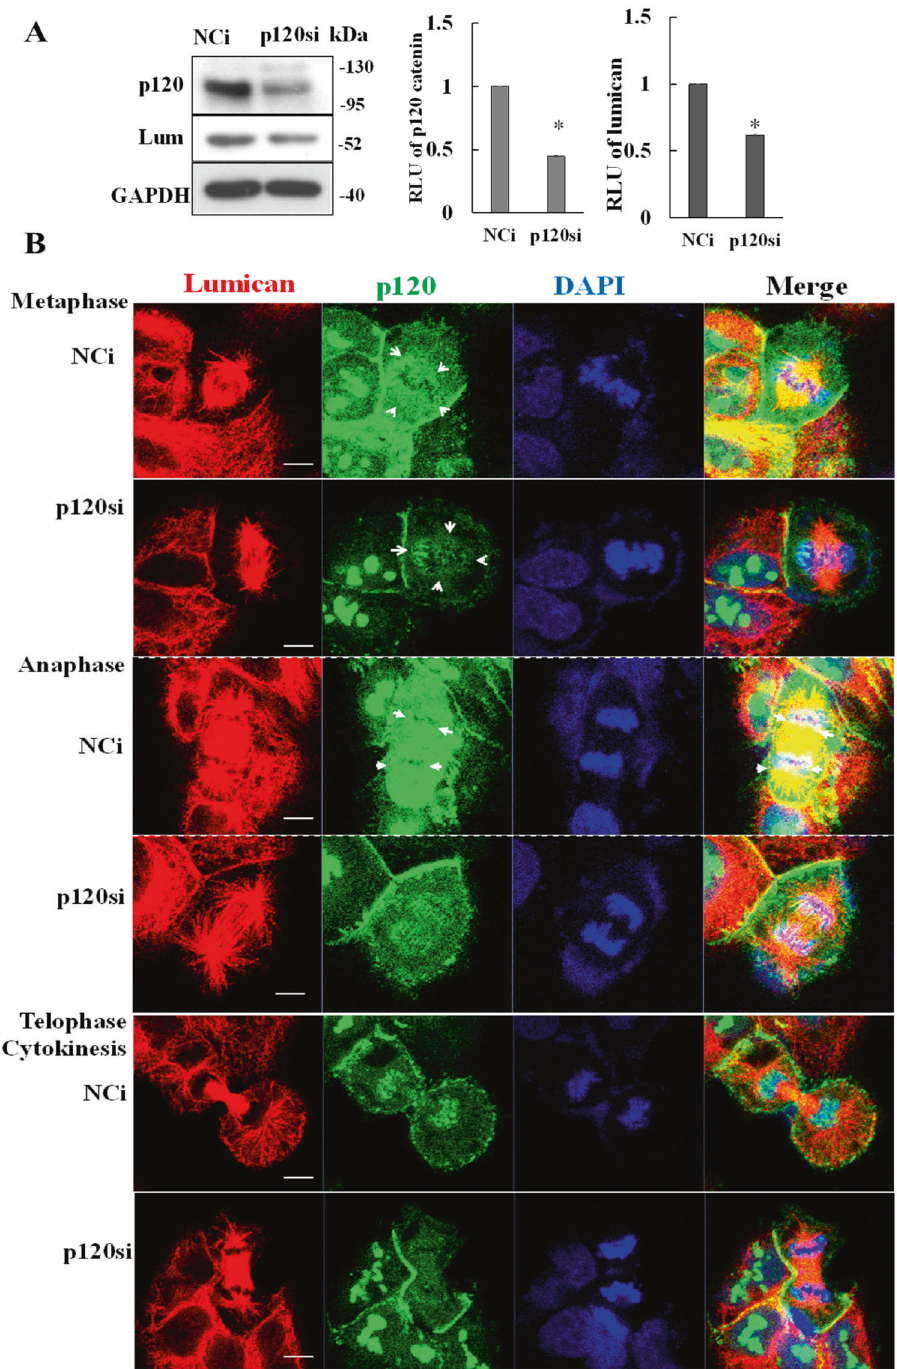
Fig. 4 Depletion of p120 catenin decreases formation of the perichromosomal layer. A Depletion of p120si effectively decreased the expression of lumican. H460 cells were transfected with p120si and harvested at 24 h. The cell lysates were subjected to western blotting using anti-lumican and anti-p120 catenin antibodies. B Depletion of p120 catenin decreased the formation of the perichromosomal layer. The transfected cells were fi xed and co-incubated with anti-lumican and anti-p120 catenin antibodies. Lumican (red) and p120 catenin (green) were detected by immuno fl uorescent staining in H460 cells. Cell nuclei were visualized by DAPI staining (blue). In addition, cells in the metaphase – telophase stage were observed. were observed in the p120si-transfected cells (Fig. 5A). The Downregulation of p120 catenin increases the incidence of number of multi-nucleated cells was about 3.47-fold higher in micronuclei and aneuploidy p120si-transfected cells than in NCi-transfected control cells To investigate whether depletion of p120 catenin induced mitotic (13.24% vs. 3.82%, Fig. 5A). Notably, p120si-transfected cells with defects, we visualized the nuclei of the NCi- and p120si-treated micronuclei were shown in Fig. 5A and B. Examination of the DAPI- cells using DAPI staining. Various sizes of rounded micronuclei